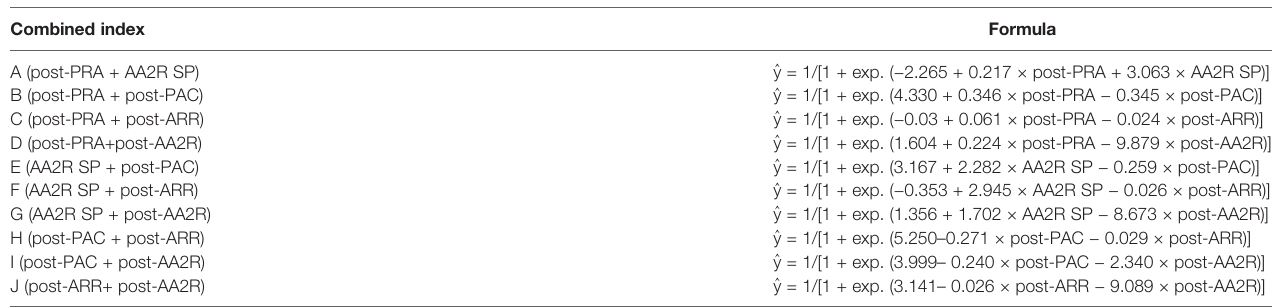
TABLE 5 | Formulas of calculating predicted probabilities of distinguishing PA from EH using different combined